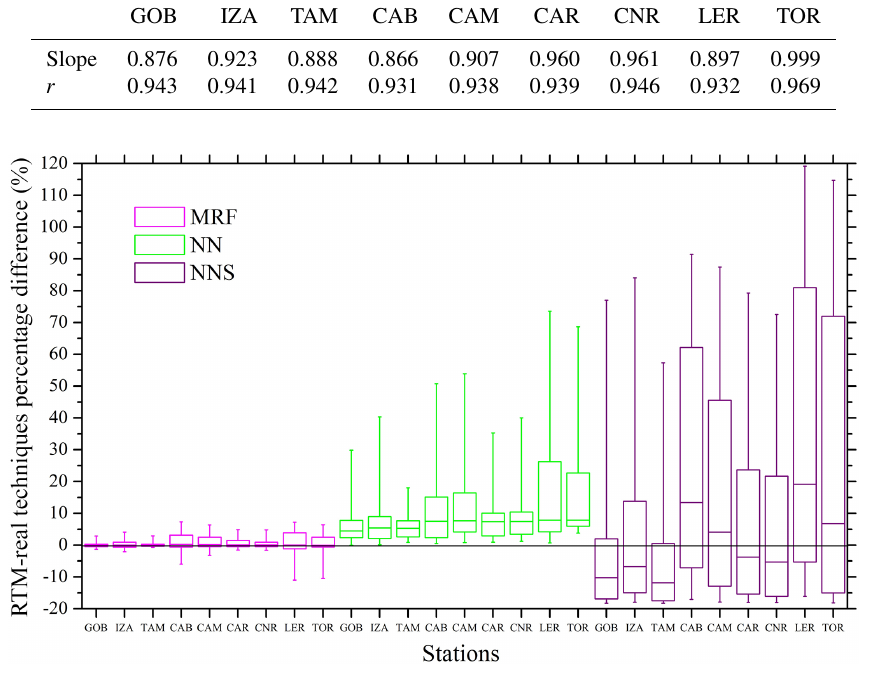
Figure 3. Percentage difference (%) of the real-time modelling techniques as compared to the RTM simulations for all ground stations. The box charts highlight the more precise estimation approach of the MRF technique as compared to the NN-based techniques.